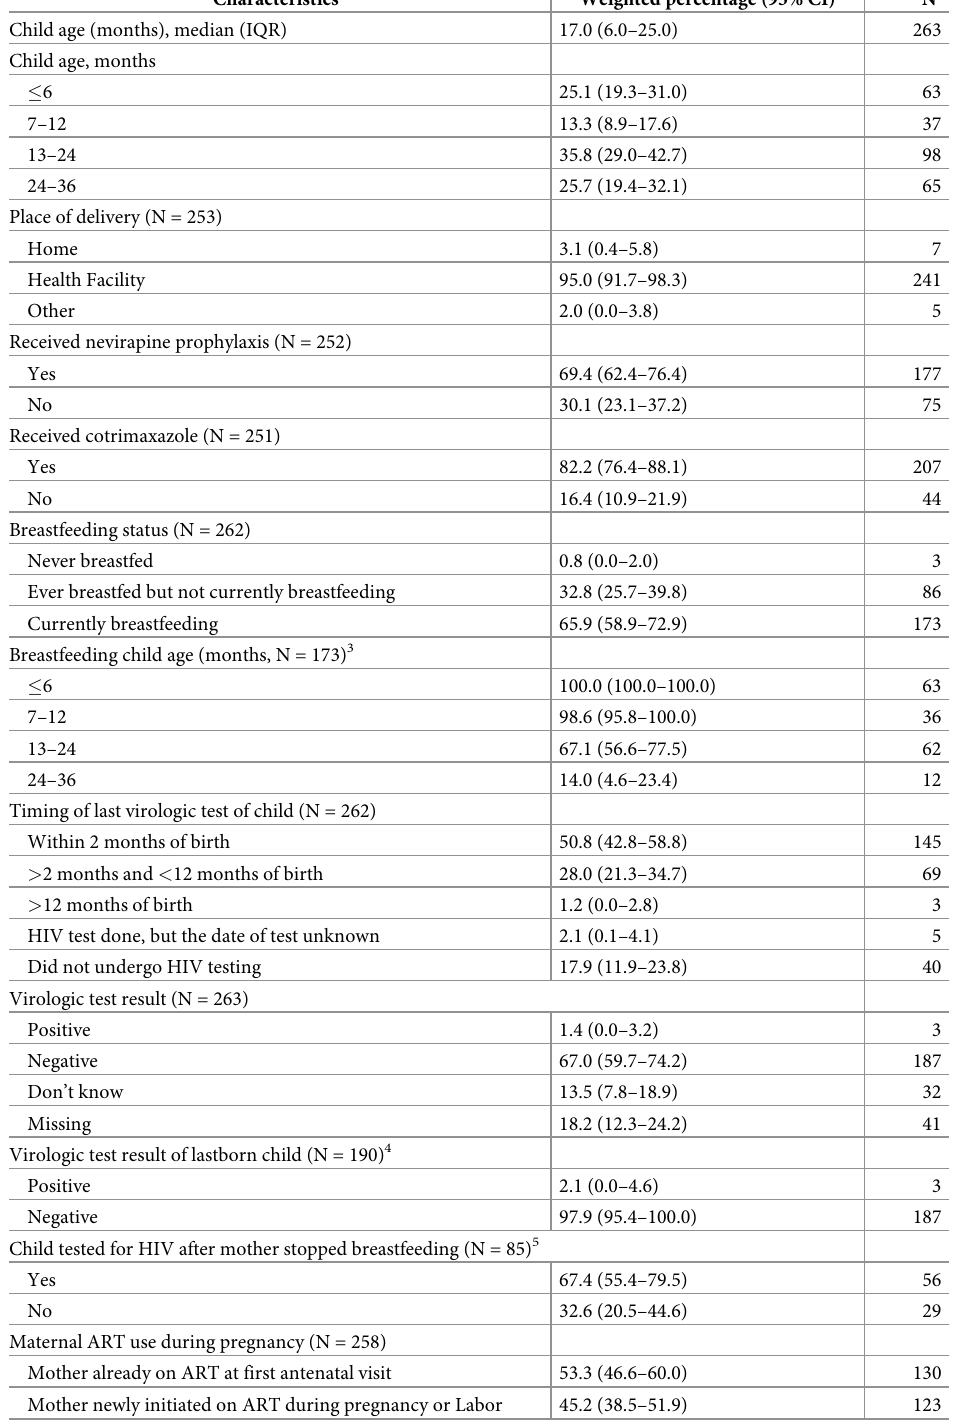
Table 3. Characteristics of HIV-exposed children 1 aged � 36 months included in the 2015–2016 Malawi Popula- tion-based HIV Impact Assessment (MPHIA) survey (N =